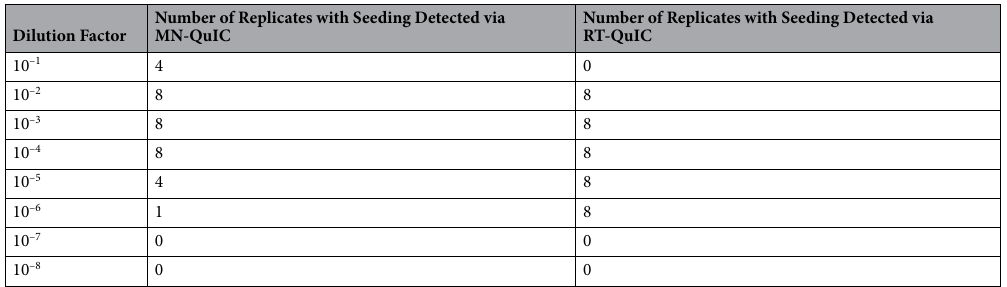
Number of Replicates with Seeding Detected via Dilution Factor MN-QuIC